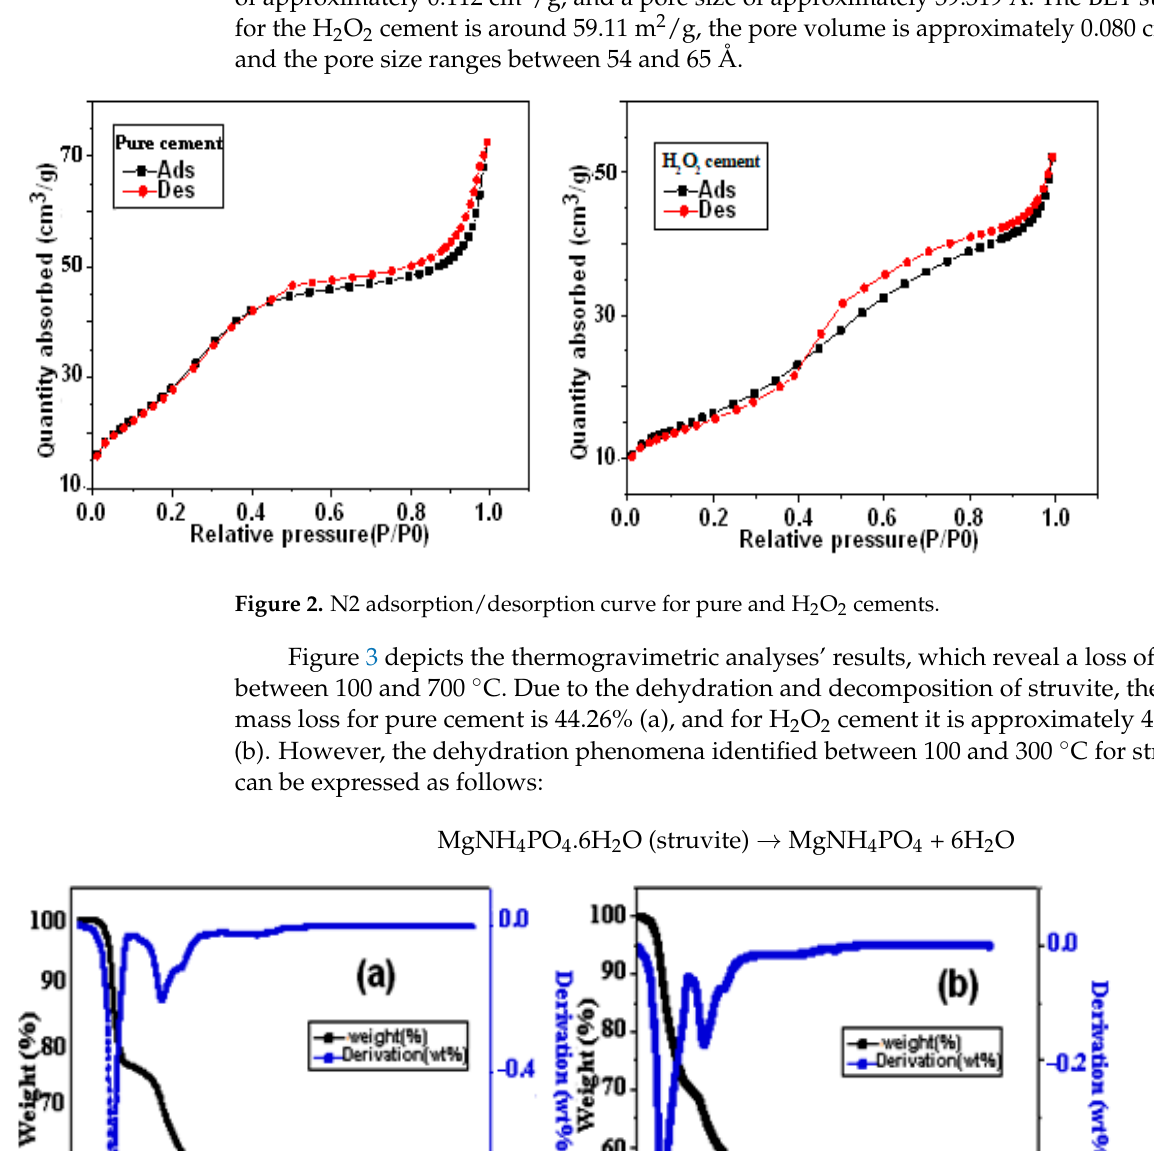
4 of 11 Figure 1. X ‐ ray diffraction pattern of pure and H 2 O 2 cements. The N2 adsorption/desorption curve for pure and H 2 O 2 cements is shown in Figure 2, and it produces the type II hysteresis curve that is most frequently observed. This graph demonstrates that multilayer adsorption and adsorption on non ‐ porous surfaces start at high pressures. Furthermore, compared to a sample made up of split pores with a size